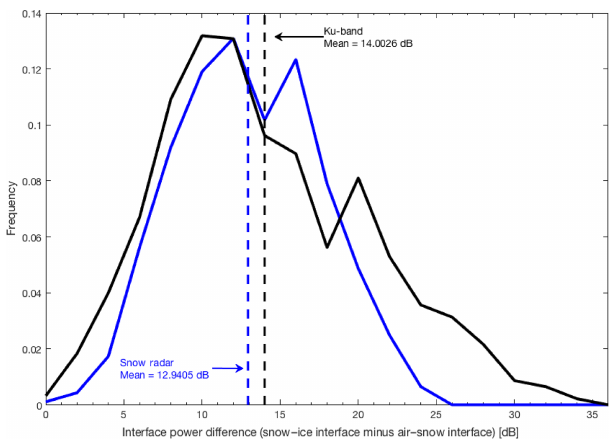
Figure 4. Frequency distributions of the difference in air–snow interface power from snow–ice interface power taken from the November 2012 IceBridge Sea Ice Endurance campaign. The blue curve represents the snow radar, while the black curve represents the Ku-band radar. Note that the locations of the air–snow and snow– ice interfaces are approximations found from the peak-picking al- gorithm (Fig. 3) and are not exactly the expected backscatter coef- ficients from the two